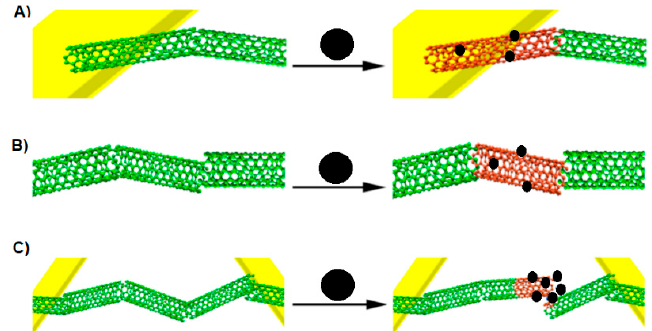
Figure 6. Three ways of CNT conductance change by analytes. ( A ) Modulation of the Schottky barrier at CNT-electrode junctions, ( B ) charge transfer between the analyte and CNT, ( C ) increasing the CNT–CNT junction distance by intercalation of the CNT network. Adapted from [26,29]. Black sphere- analyte, green cloud—current allowed, red cloud—current inhibited.